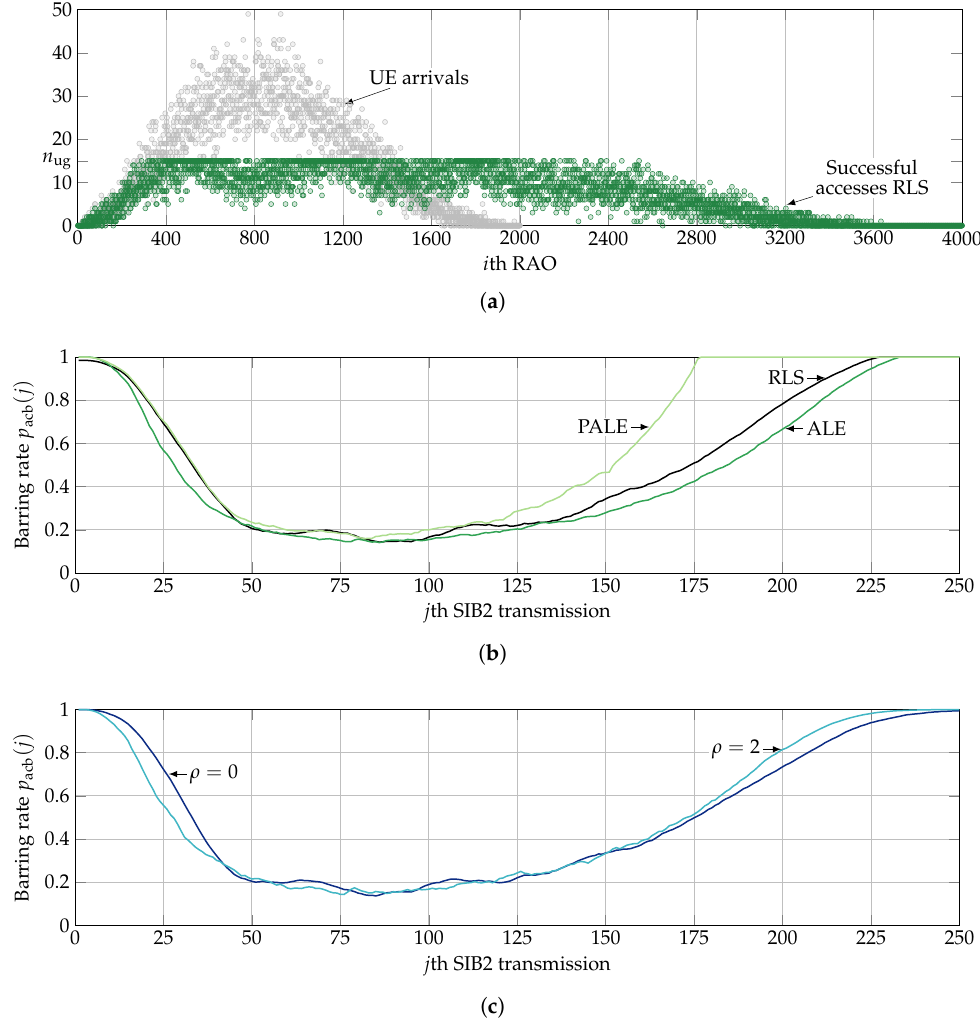
Figure 8. ( a ) Number of UE arrivals a ( i ) and successful accesses s ( i ) per RAO with the RLS algorithm, and barring rate p acb ( j ) calculated at the j th SIB2 for a single simulation run and r = 54 under the traffic model 2 with the ( b ) RLS, ALE LMS, and PALE LMS and ( c ) LPF with ρ ∈ { 0,2 } . Results derived from a single